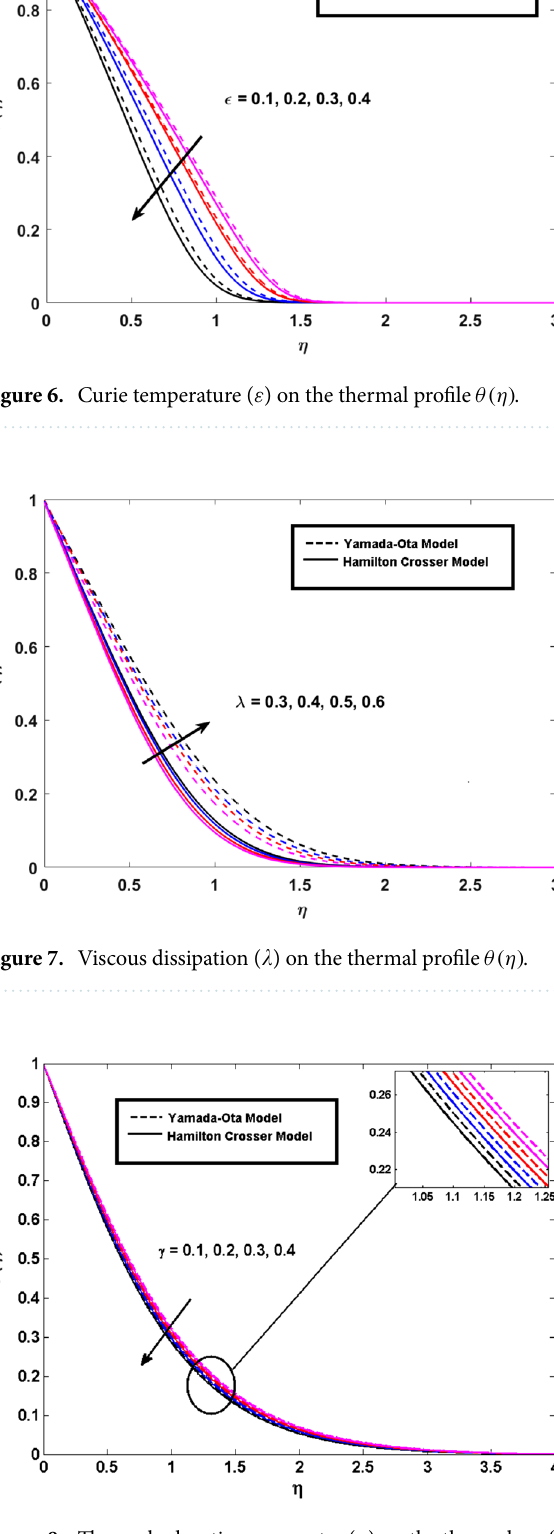
Figure 8. Thermal relaxation parameter ( γ ) on the thermal profile θ(η)